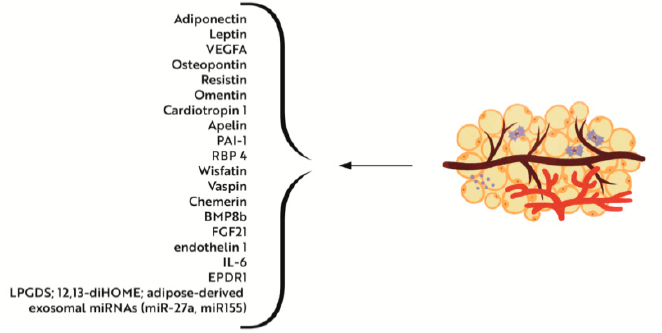
Figure 2. Lipocrinology—adipose tissue as an endocrine organ is able to secrete a lot of hormones with crucial metabolic effect.